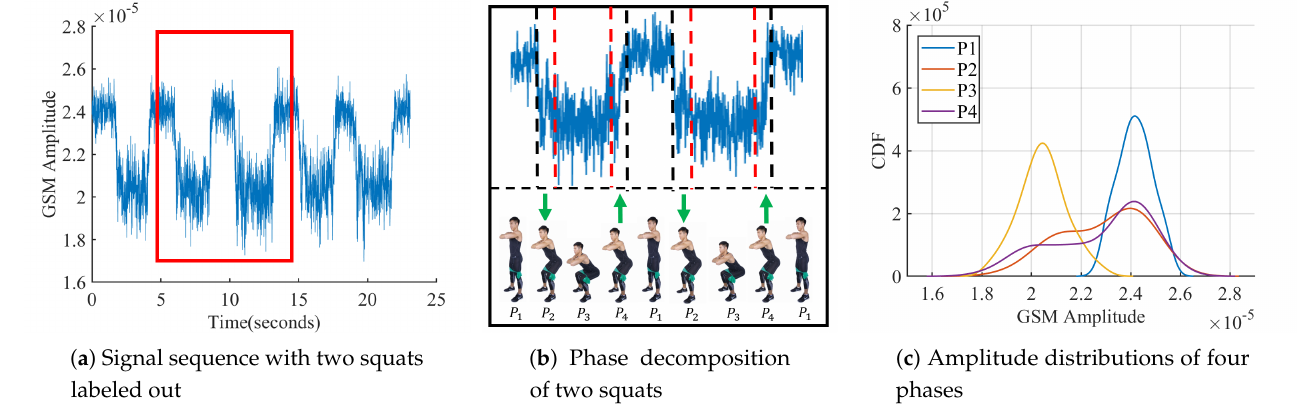
Figure 4. Down-sampled signal sequence while squatting [15].